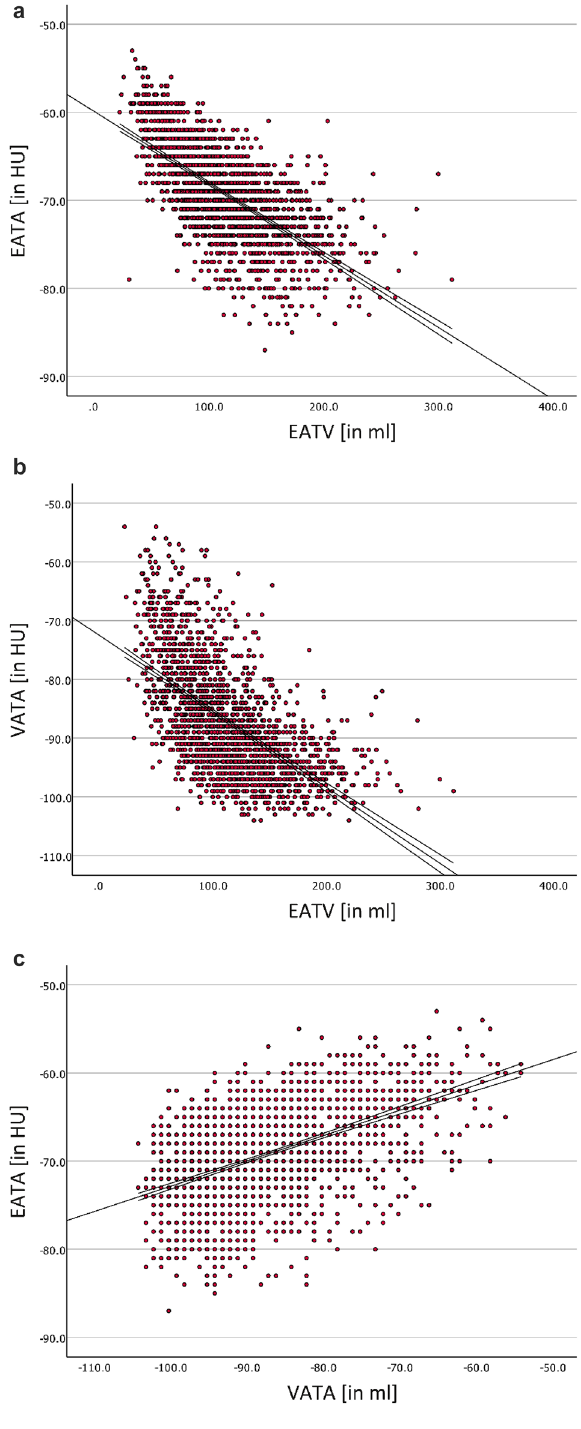
Figure 1. ( a ) Regression plot showing the relationship between epicardial adipose tissue attenuation (EATA) and epicardial adipose tissue volume (EATV). The regression line with its 95% CI is shown in black [B = 0.082, R = 0.665, p < 0.01]. ( b ) Regression plot showing the relationship between visceral adipose tissue attenuation (VATA) and epicardial adipose tissue volume (EATV). The regression line with its 95% CI is shown in black [B = (− 0.129), R = 0.589, p < 0.01]. ( c ) Regression plot showing the relationship between epicardial adipose tissue attenuation (EATA) and visceral adipose tissue attenuation (VATA). The regression line with its 95% CI is shown in black [B = (− 0.288), R = 0.514, p <